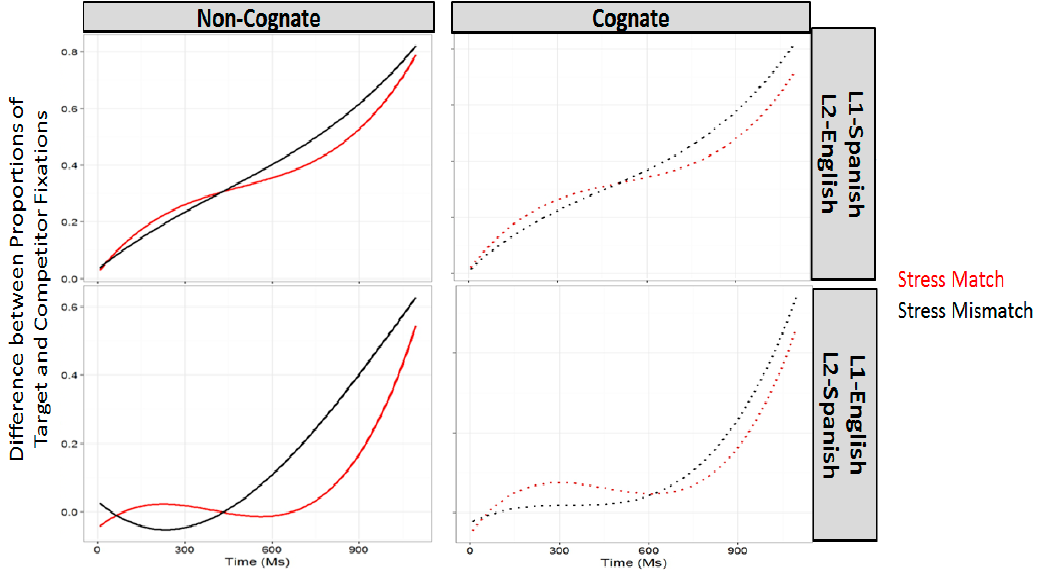
Figure 1. Growth curve analysis results.